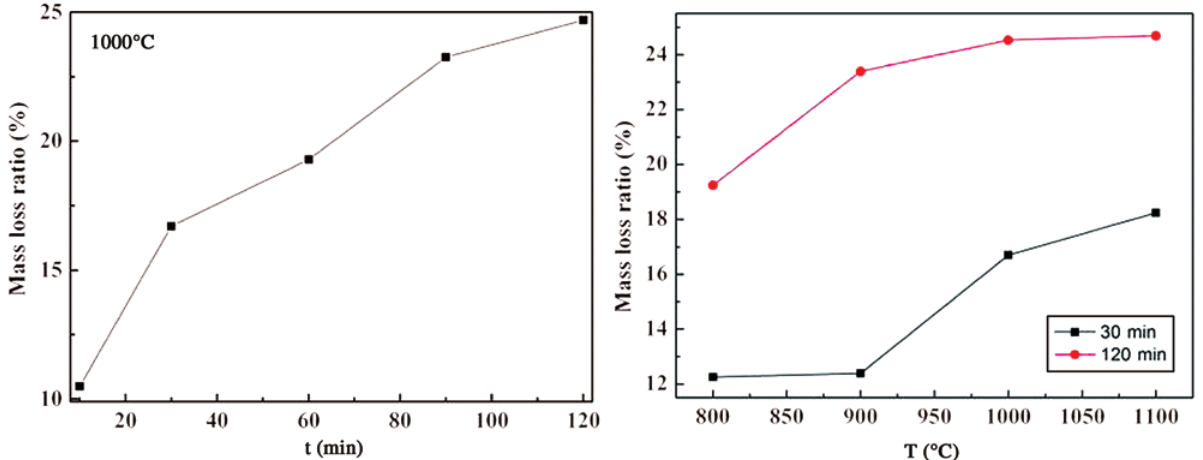
Figure 3: Effect of reduction time or temperature on the mass loss ratio of the reduced samples.